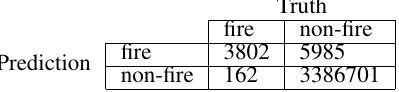
Table 4. Testing results of the fixed threshold model.